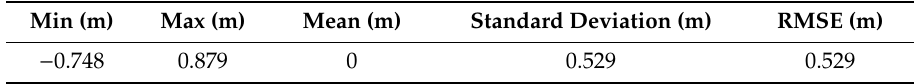
Table 8. Statistical values of the residuals for the North coordinates resulting from datum transformation UTM / ED50 to UTM / WGS84 based on a conformal approach.